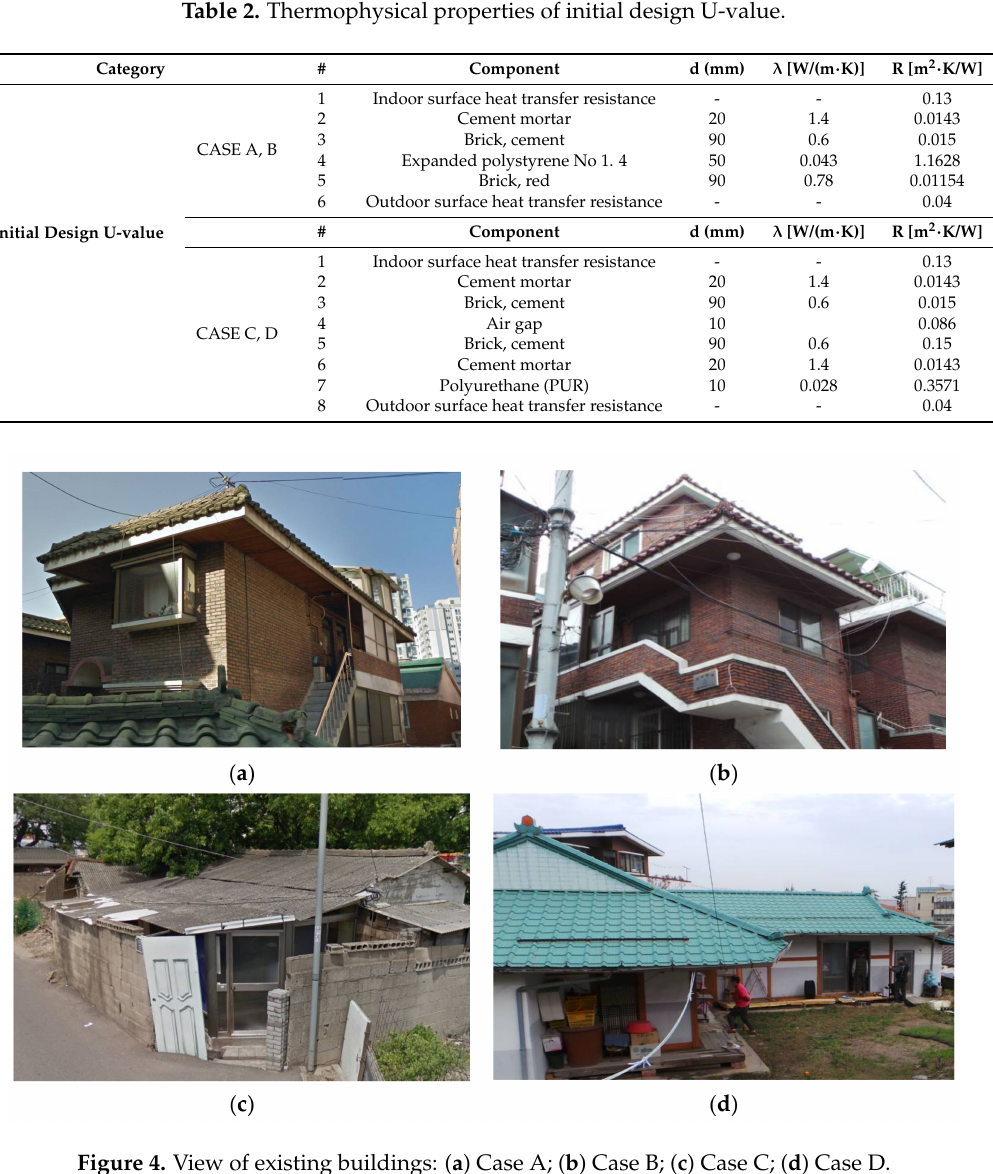
Figure 4. View of existing buildings: ( a ) Case A; ( b ) Case B; ( c ) Case C; ( d ) Case